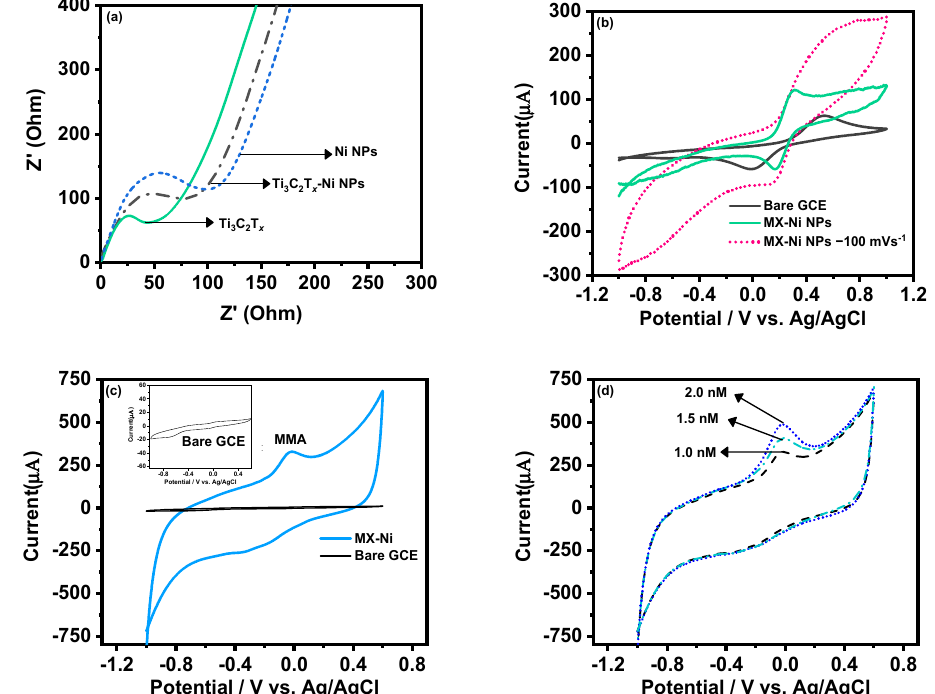
Figure 4. ( a ) EIS-based Nyquist plots for MX − Ni composites; ( b ) CV curves for MX − Ni composite in K 4 [Fe (CN) 6 ]/K 3 [Fe (CN) 6 ] in 0.1 M KCl in reference to bare-GCE and pristine Ni NPs modified GCE at 50 mVs − 1 and 100 mVs − 1 ; ( c ) the electrochemical response of MX − Ni against 0.001 µ M MMA; ( d ) corresponding CV based reductive current increment observed against different concentration in the range from 1.0 to 2.0 nM MMA at the scan rate of 50 mVs − 1 . The CV curves for pristine Ni NPs and Ti 3 C 2 T x modified GCE in 0.1 M PBS at a scan rate of 50 mVs − 1 are shown in Figure S2b. Unlike Ni NPs, which exhibit a typical redox couple for Ni (II) and Ni (III) ions, the Ti 3 C 2 T x could only display a large conductive current owing to its relatively weak redox activity in a neutral PBS system. Figure 4c shows the CV curves for MX − Ni composites against 0.001 µ M of MMA in 0.1 M PBS (pH 7.0) in reference to bare GCE a fixed scan rate of 50 mVs − 1 . The bare GCE had no activity against MAA (inset Figure 4c), whereas the MX − Ni successfully produced a cathodic reduction current response near 0.0 V, which was attributed to the reduction of MMA to 2-methylpropane-1,3- diol [29]. The response was recorded for different MMA concentrations (0.001 to 0.002 µ M) at 50 mVs − 1 (Figure 3d), realizing a stable peak for each concentration confirming MX − Ni composite’s steady electrocatalytic activity towards MAA. Figure S3a shows the variation of peak current against different scan rates in the range from 50 to 110 Vs − 1 , whereas the plot of peak current against the square root of scan rate (Figure S3b) further indicated the surface redox process to be diffusion controlled. Figure S3c shows the peak current variation against different pH in the range of 3–9 for MX − Ni against MMA (0.001 µ M).